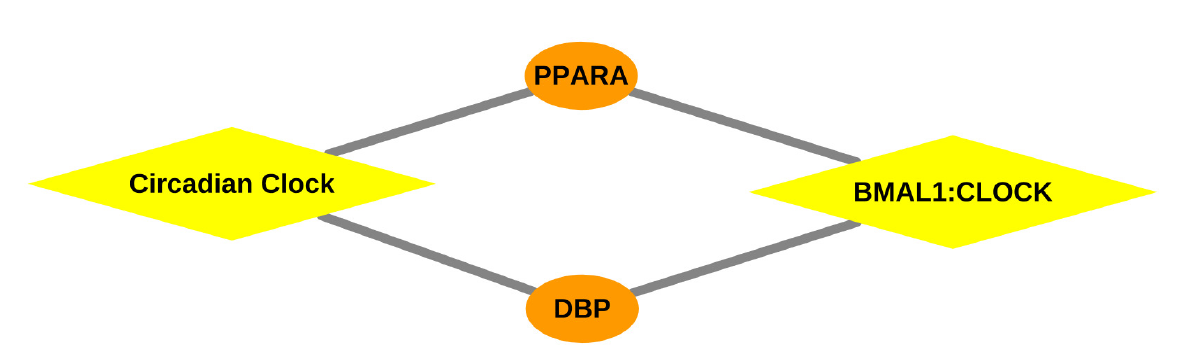
Figure 4. Gene-pathway network: Network representing the association between the over-represented pathways and transcription factors, especially DBP , depicted for the liver, spleen and lymph node tissue of N’Dama. Orange coloured ellipses in the network represent the transcription factor genes and yellow coloured rhombuses indicate the over-represented pathways. The transcription factors are connected to the pathways, thereby forming a network of interactions between